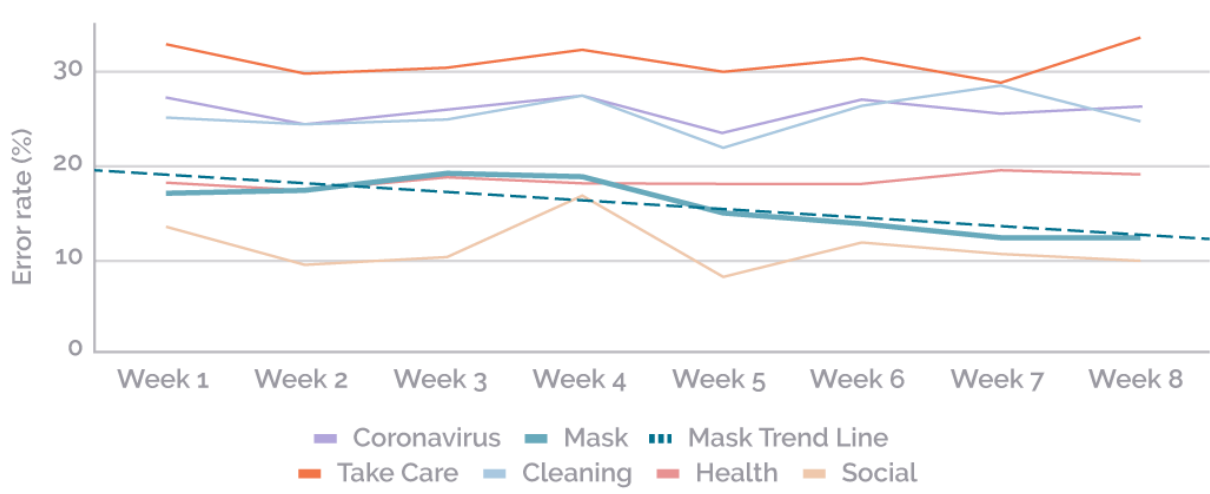
Figure 10. Error rates by topic grouped by week (July 20 to September 13, 2020). The linear trend for the Mask topic is significant ( r